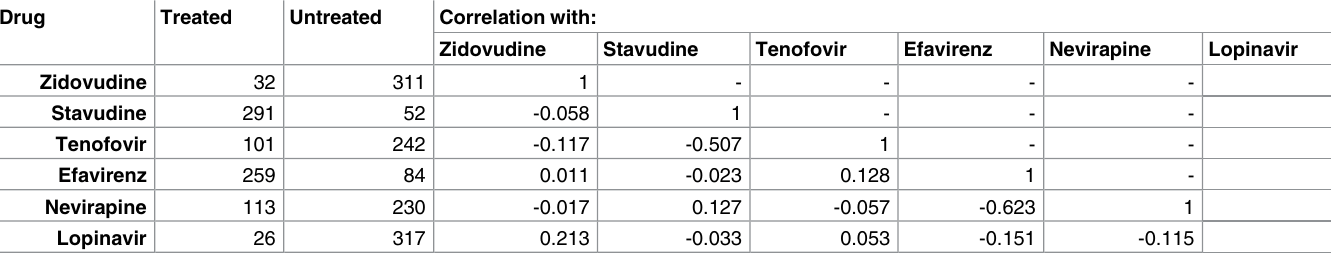
Table 1. Number of WGS treated with each drug, and correlations between drugs within samples. Drug